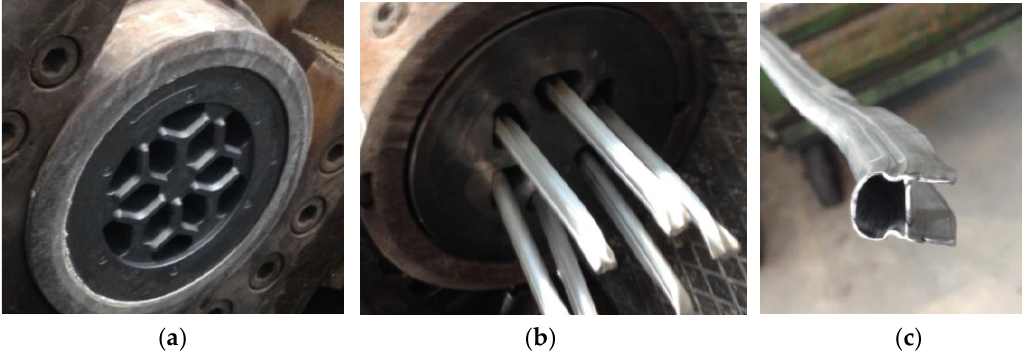
Figure 12. Experimental observations: ( a ) The upper die, ( b ) the extruded profiles, and ( c ) the nose end of the extruded profile with a slight shape distortion.